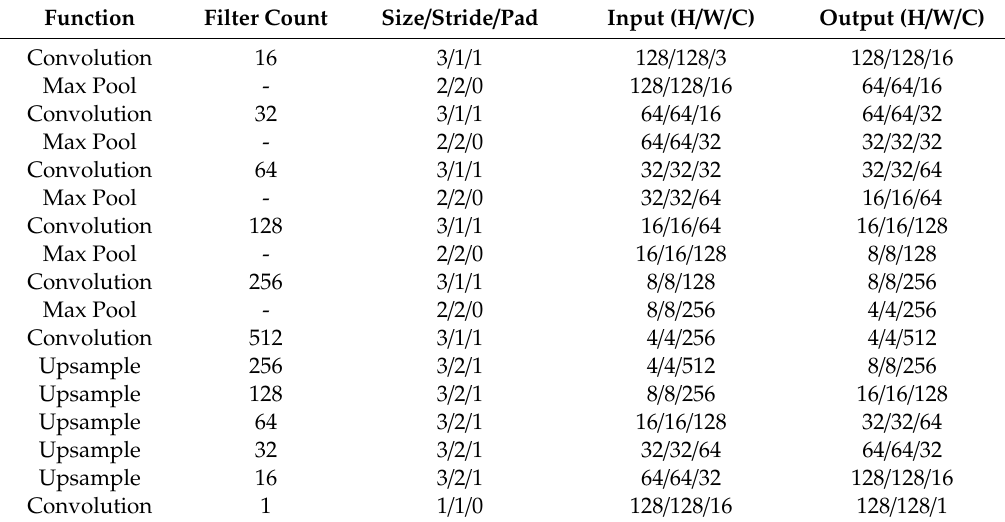
Table 2. Structure of the network in this paper.